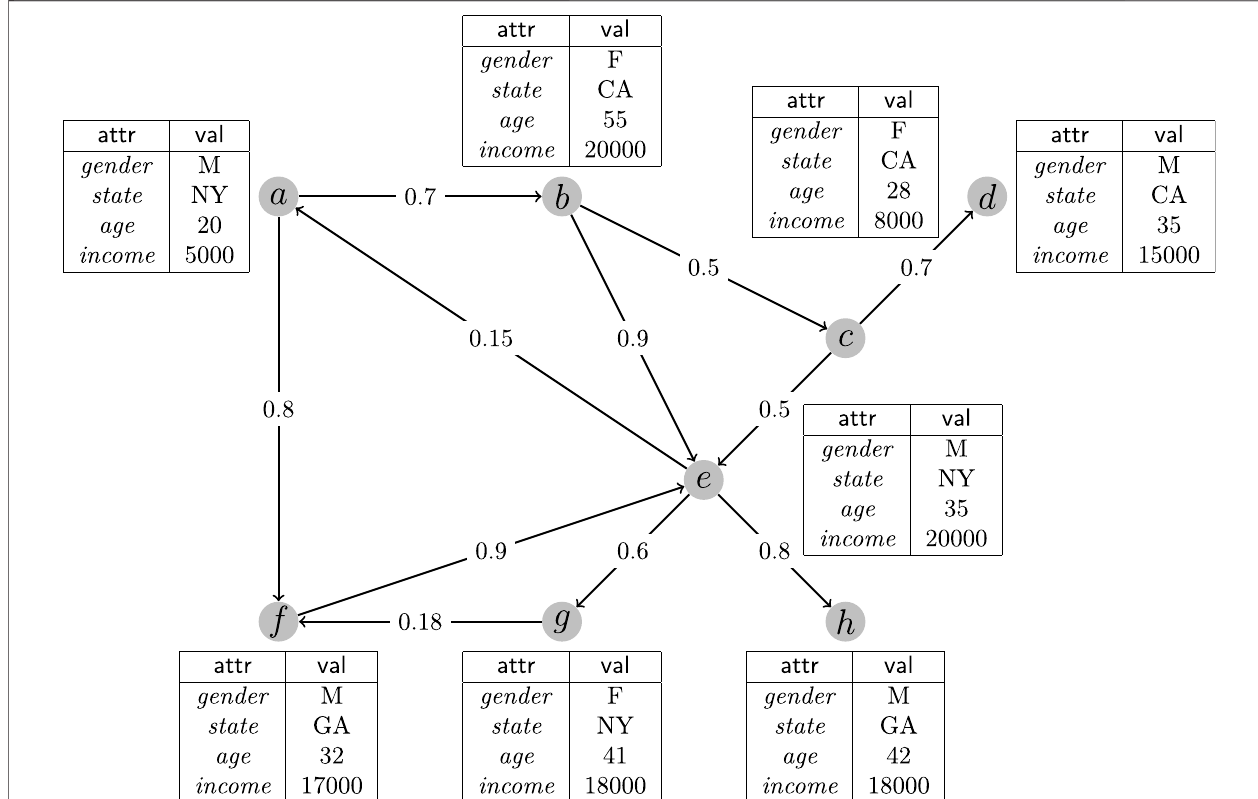
FIGURE 1 | A motivated example of multidimensional selection based targeted in fl uence